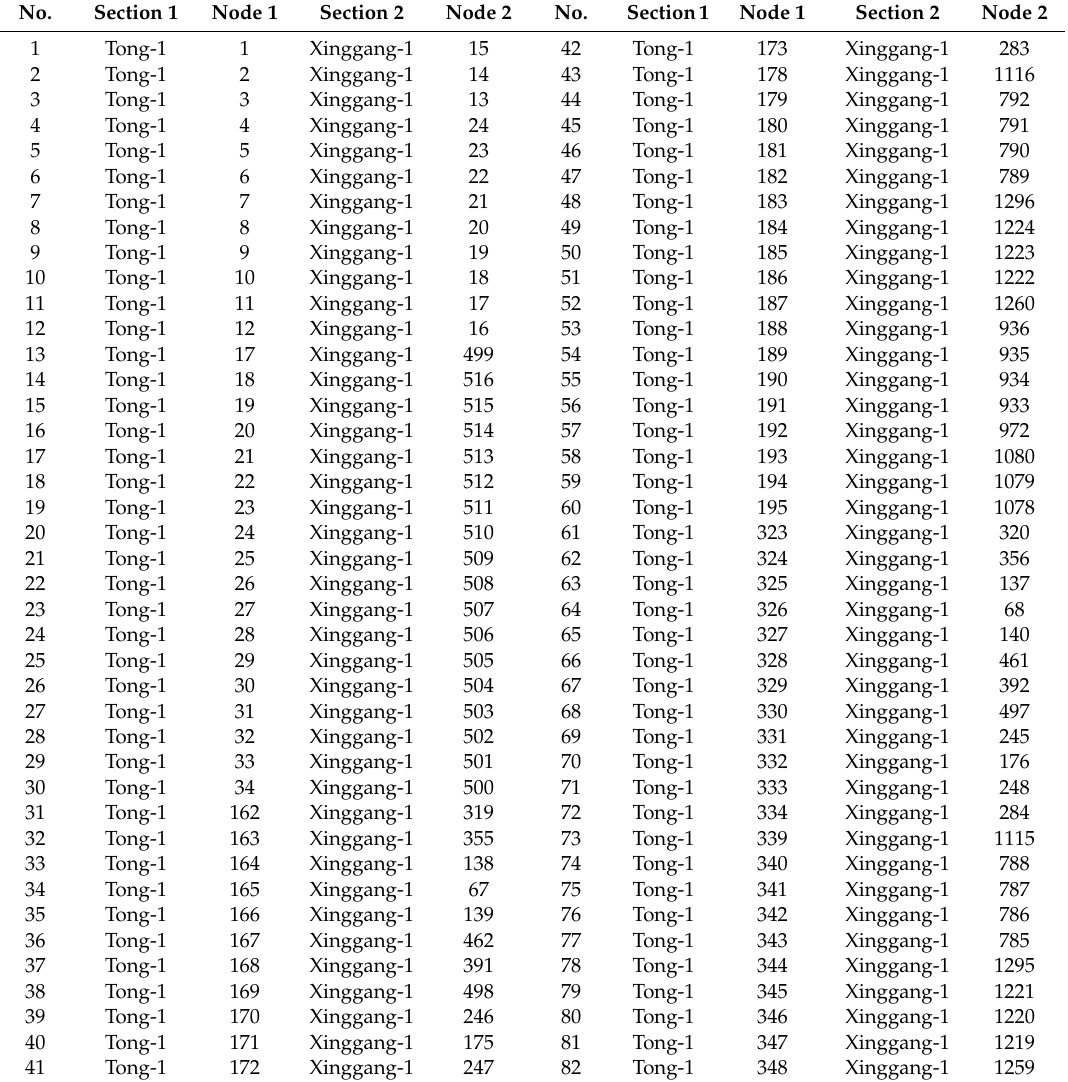
Table 9. Relationship of node for SRRC-1.